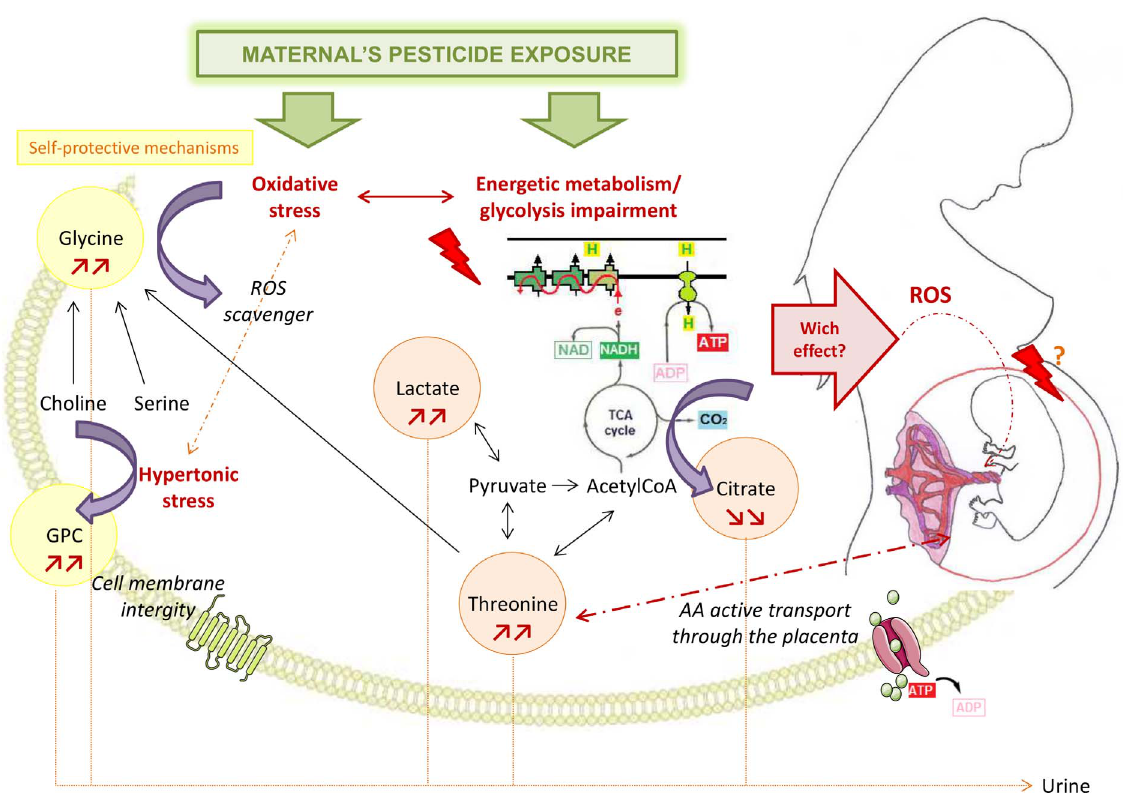
Figure 4. Suggested mechanisms of action of complex and low-dose pesticide mixtures. These suggestions are based on the modification of 1 H NMR urinary metabolic profile of pregnant